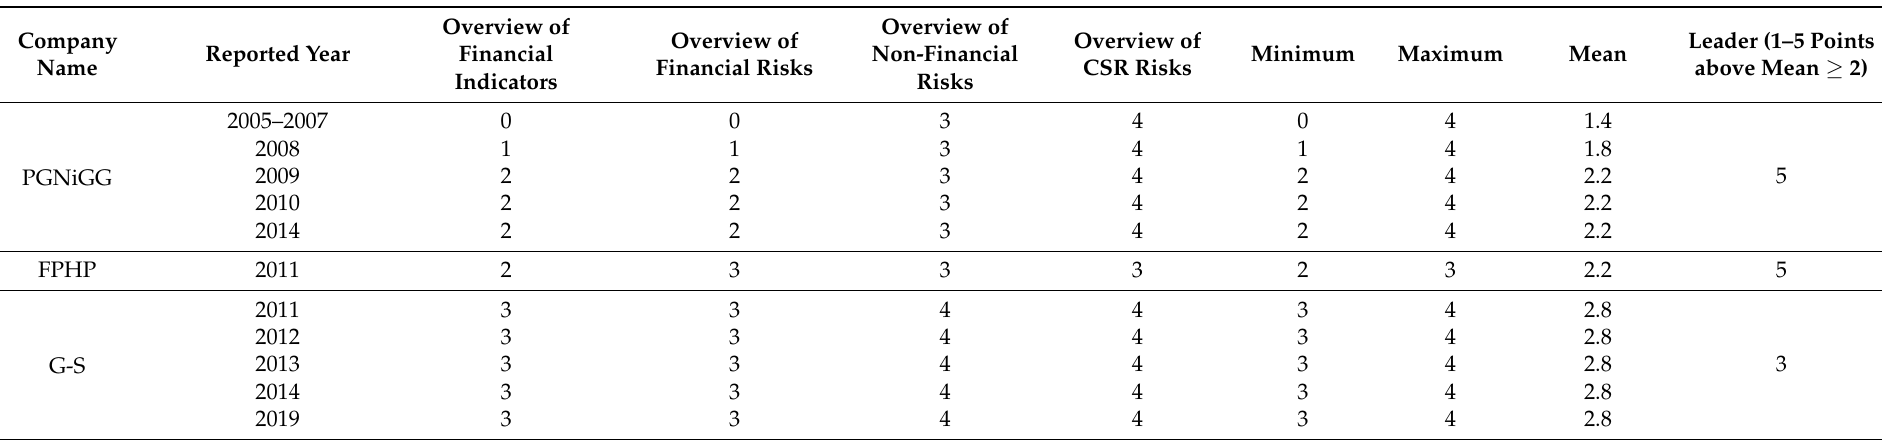
Table 6. Information on company’s financial condition and risks in the analysed corporate annual